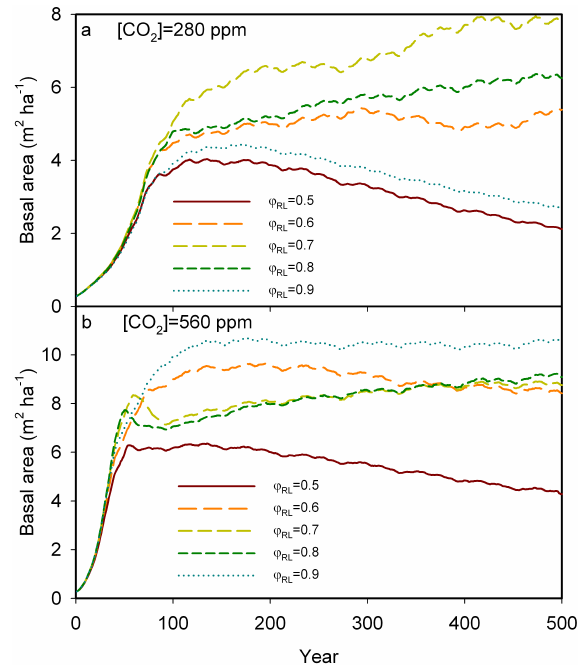
Figure 8. Competition among PFTs that differ only their allocation to fine roots. Competition experiments were performed at two at- mospheric CO 2 concentrations: 280 (a) and 560ppm (b) . In each experiment, a simulation was initialized with equal seedling densi- ties of five PFTs that differed only in their ratio of fine-root area to leaf area ( ϕ RL ) . Because all PFTs shared the same target crown LAI, ϕ RL primarily determines allocation to fine roots and wood.